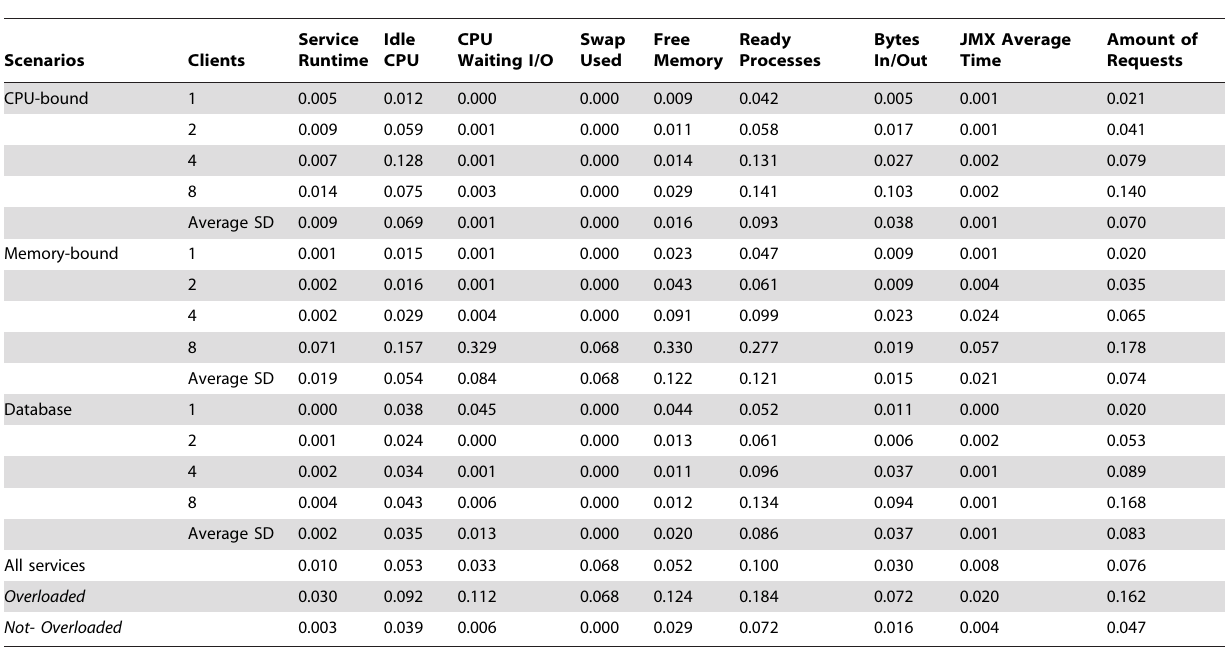
Table 4. Standard deviation (SD) representing the stability of the load